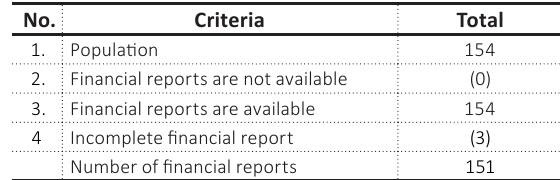
Table 1. Summary of the final